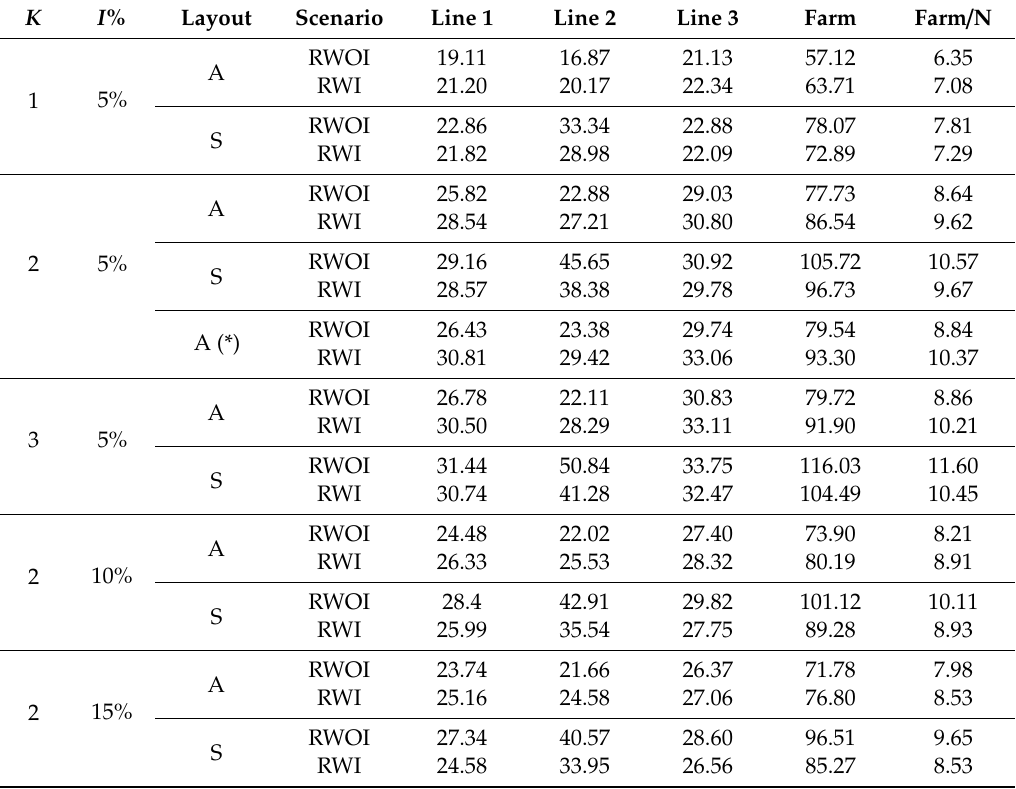
Table 5. Energy produced during the mean tide (MWh) for K = 1, 2, and 3 and t = 5% configurations. The energy is calculated either for each line or for all the turbines (farm). The column farm / N, where N is the number of machines of the farm, indicates the mean energy delivered per turbine. Energies are computed for the two scenarios (RWOI and RWI) and aligned and staggered layout. (*) The power captured by a machine is calculated by using the local velocity along x-axis (15). Replacing the local velocity along x by the local velocity magnitude puts to the fore the impact of the flow obliquity on the production of a tidal